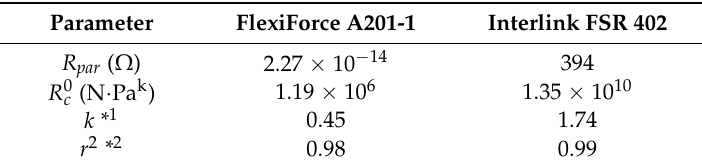
Table 2. Parameters obtained for the contact resistance, R c , on the basis of the proposed model of Equation (34). Parameters obtained at the third